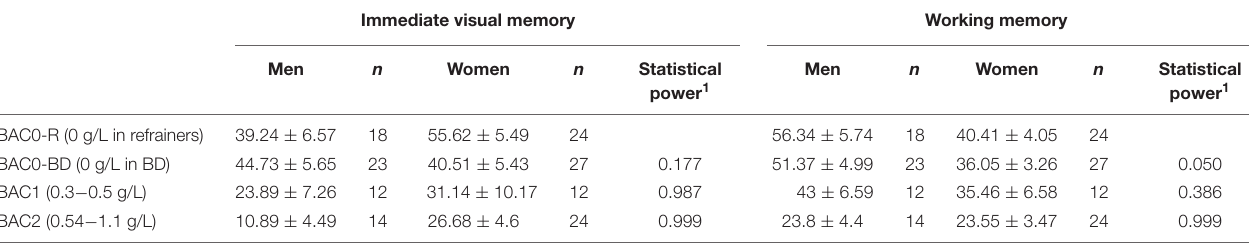
TABLE 2 | Descriptive statistics for IVM and WM.